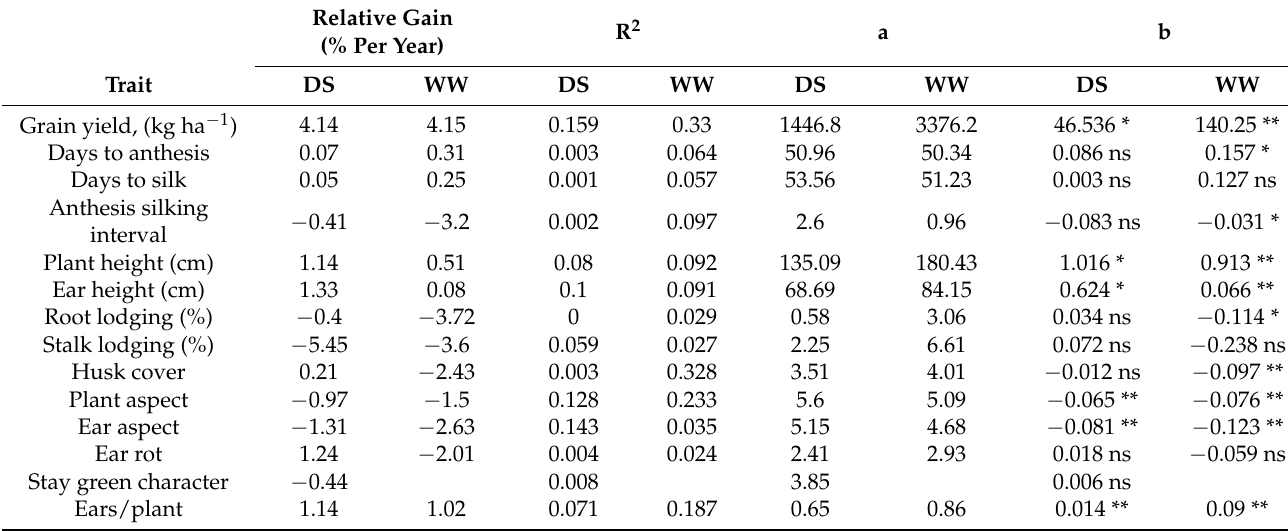
Table 4. Relative genetic gains of grain yield and other traits of extra-early hybrids of three breeding periods assessed under drought environments between 2016 and 2019 and rainfed environments between 2016 and 2017 in